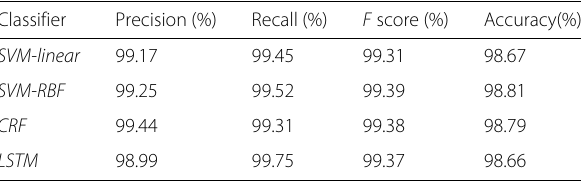
Table 6 The classification performance of style classifiers evaluated on LOTUS-DEV and Cell-DEV